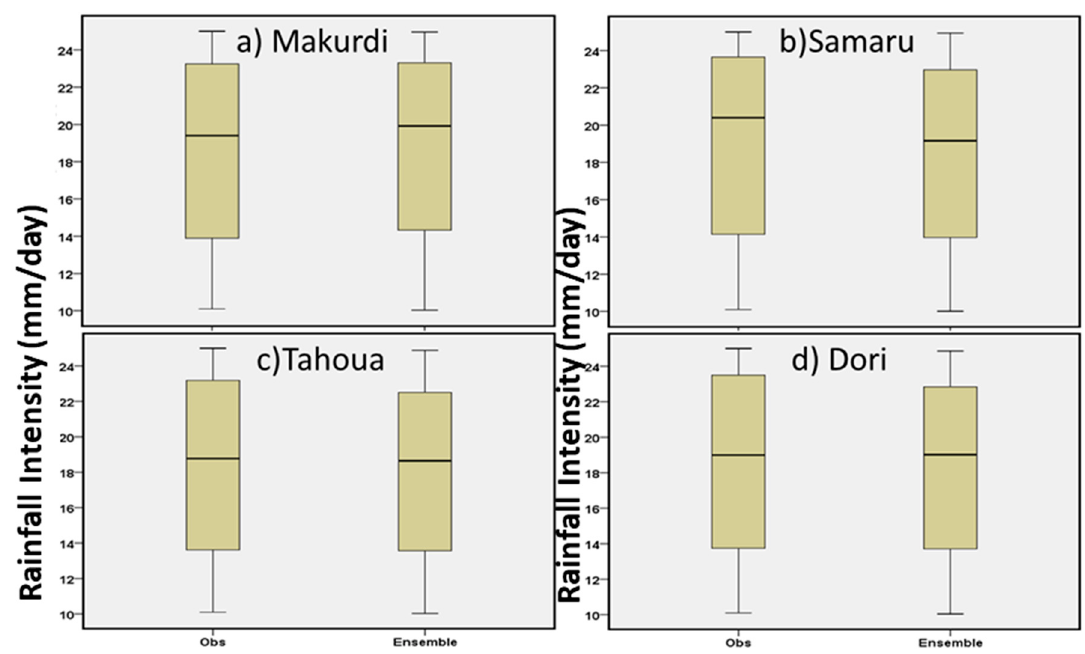
Figure 4. Box and whisker plot comparing the CORDEX multi-models ensemble and observed mean daily moderate rainfall intensity (>10 to ≤ 25 mm) over the ( a ) Southern (Makurdi) and ( b )Northern (Samaru) Guinea agro-ecological zones and the ( c , d ) Sahelian (Tahoua and Dori) agro-ecological zones for the historical period, 1976/1980–2005 .